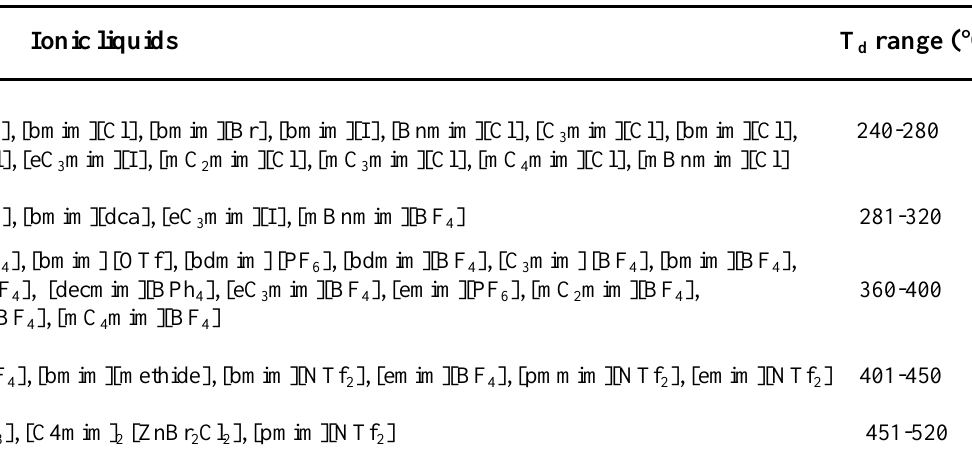
for some imidazolium ILs d